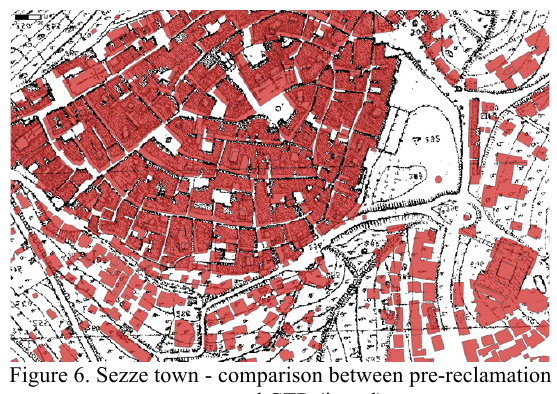
Figure 6. Sezze town - comparison between pre-reclamation maps and CTR (in red)